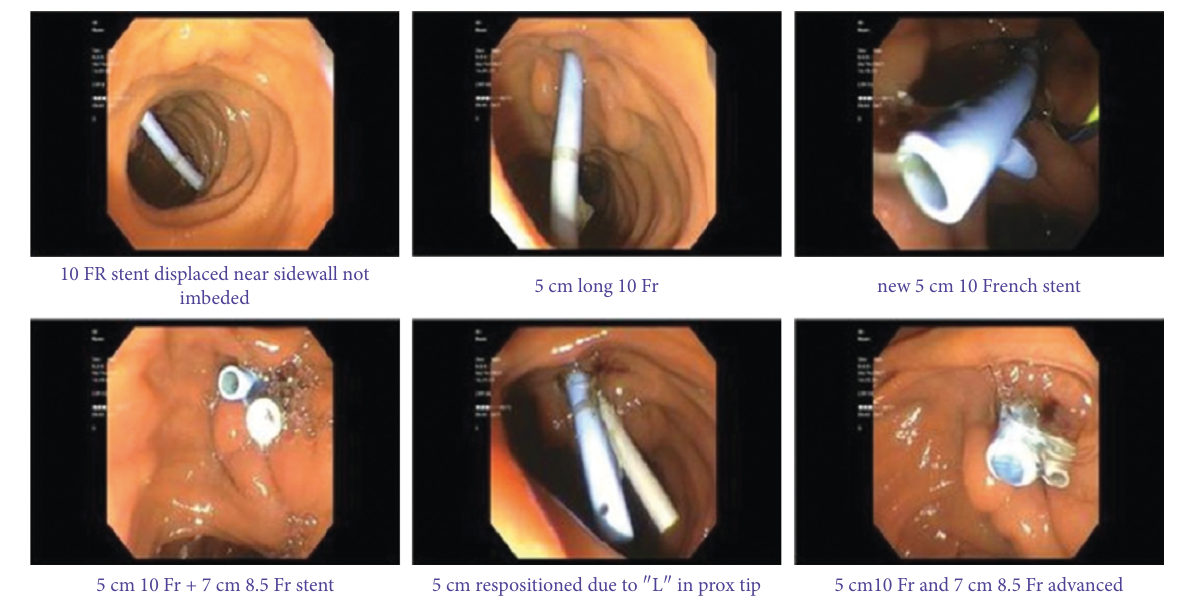
Figure 1: ERCP images showing (in order) stent removal and replacement with a new 5cm 10 French stent and 7cm 8.5 French